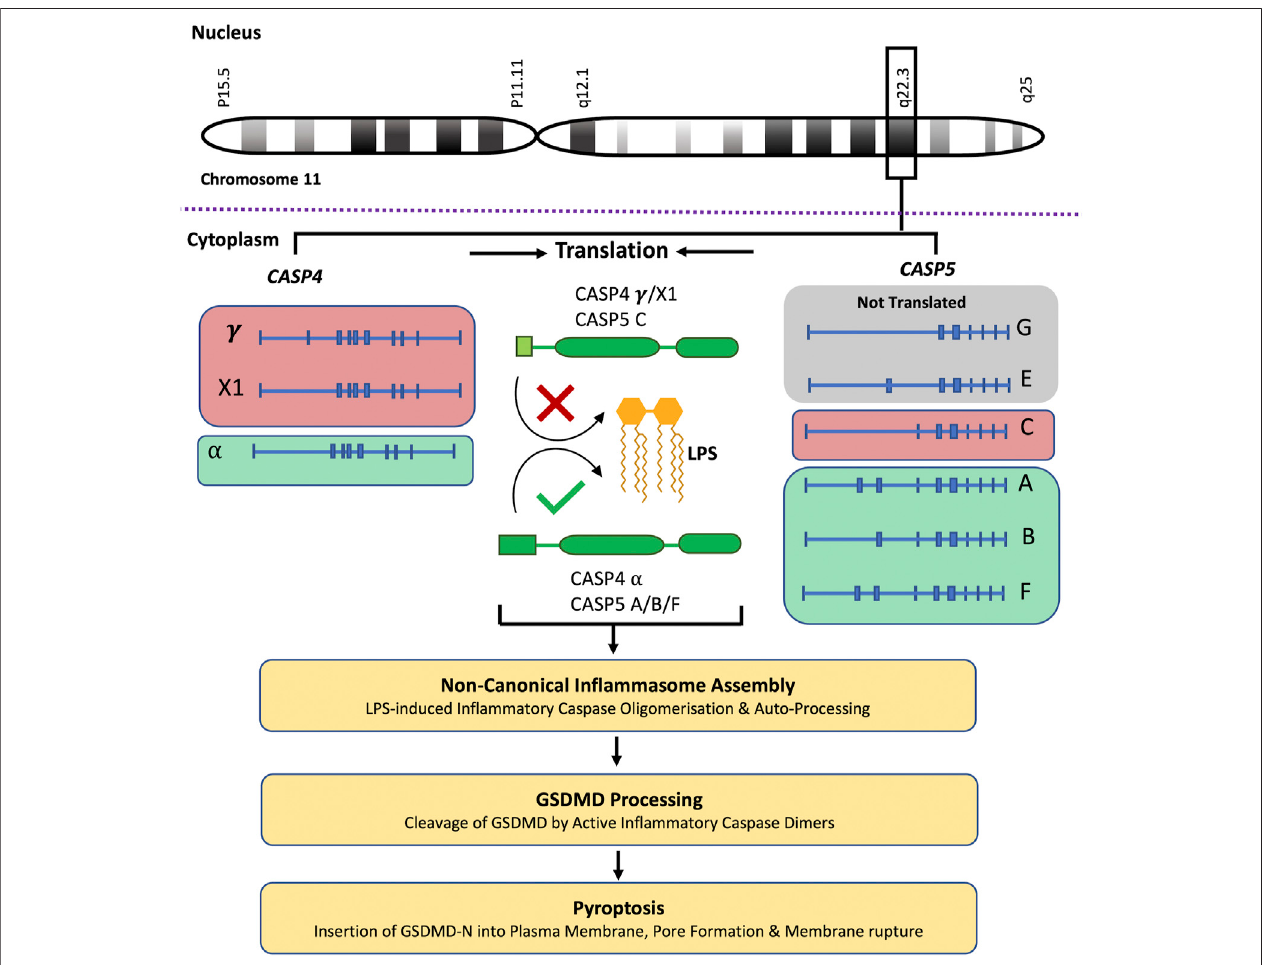
FIGURE 2 | Caspase-4 and -5 variants and predicted functions. The CASP4 and CASP5 genes are located next to each other on chromosome 11, q22.3. NCBI RefSeq database lists three CASP4 mRNA ( α , γ and X1) which are translated into their cognate protein variants, and six CASP5 mRNA (A, B, C, E, F and G) transcripts. Although CASP5 codes for 6 mRNA transcripts, the G and E transcripts are not translated. The CASP4 ( γ and X1) variants and the CASP5 (C) variant are shortened at their N-terminal regions, resulting in the loss of residues identi fi ed as being crucial for LPS binding and CARD oligomerisation. These changes in the CARD primary structurecouldsigni fi cantlyalterorprevent CASP4 ( γ andX1)variantsand CASP5 (C)variantactivationinresponsetointracellularLPS,limitingtheirsubsequentabilityto processGSDMDandinducepyroptosis.Thisanalysispredictsthatonlyone CASP4 isoformiscapableofGSDMDcleavage,while CASP5 expressesmultiplepotentially active